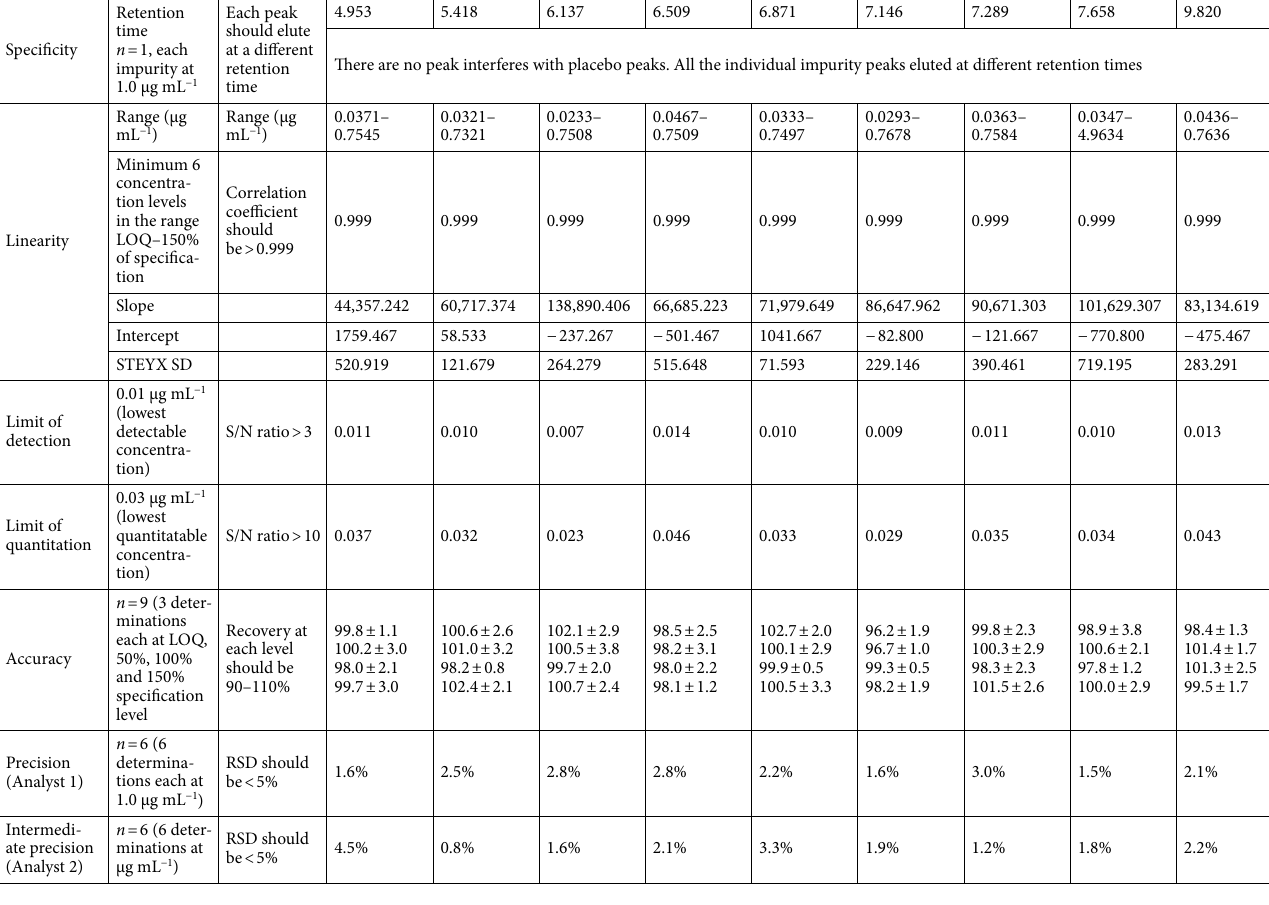
Table 4. Method validation